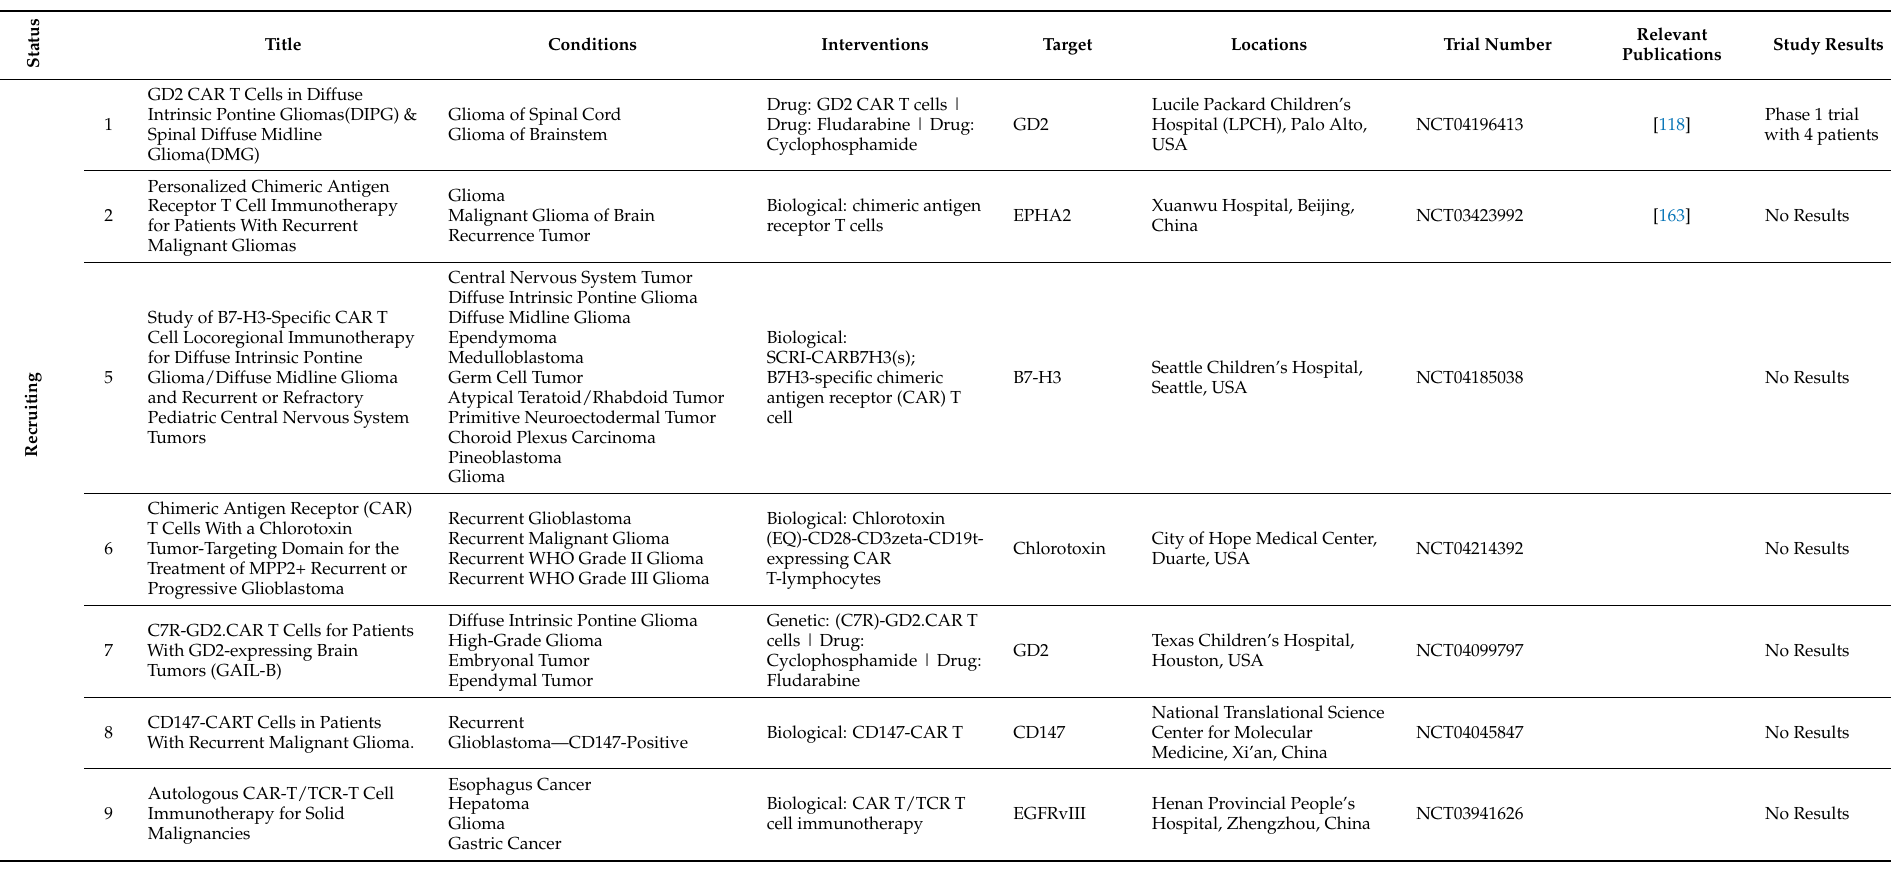
Table 2. List of past and current CAR T trials in primary brain tumors (from